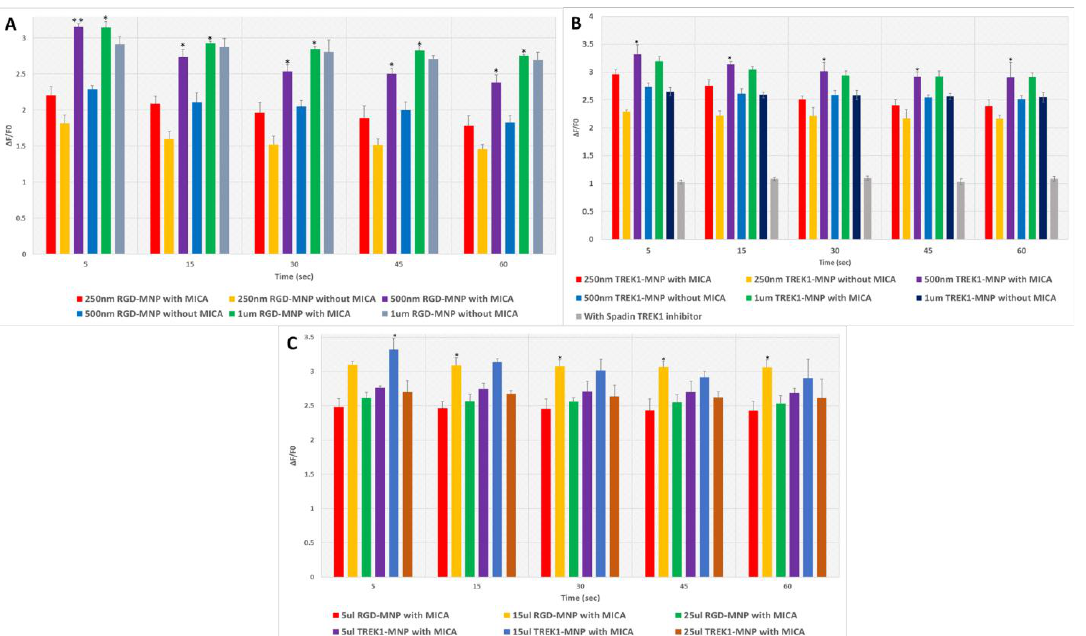
Figure 4. Time-dependent Fluo-8AM response with HEK293 cells labelled with ( A ) RGD-MNPs, ( B ) TREK1-MNPs, and ( C ) concentration-dependent Fluo-8AM response with time after MICA application for 30 s (asterisks indicate significance in results using ANOVA test (* p < 0.05)).